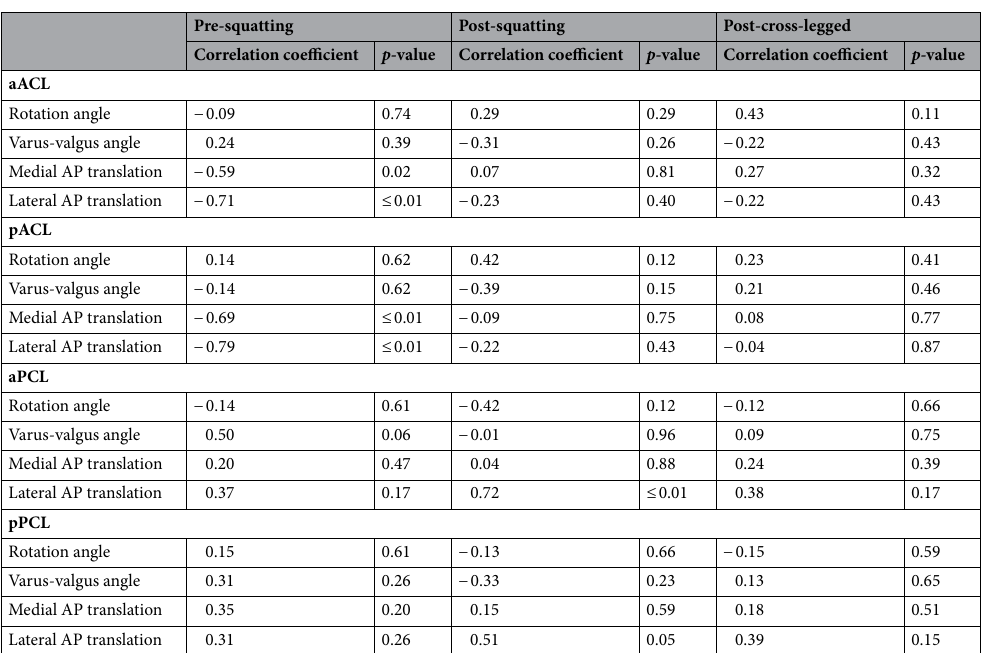
Table 2. Correlation between differences in knee kinematics and cruciate ligament force for each activity. aACL: from 10° to 60° flexion; pACL: from 10° to 30° flexion; aPCL: from 60° to maximum flexion; pPCL: from 30° to maximum flexion.